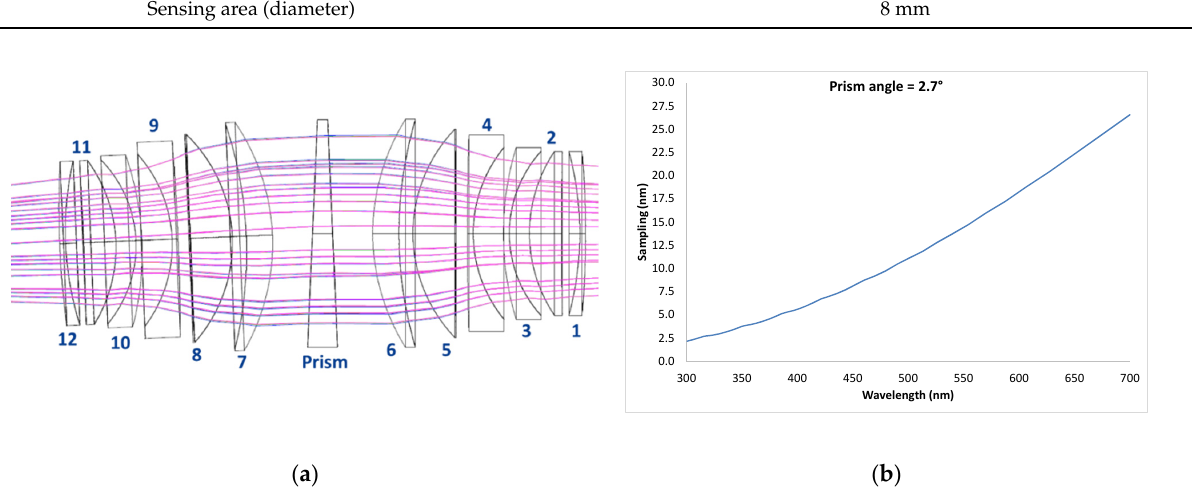
Table 3. List of spectrometers optical elements materials.